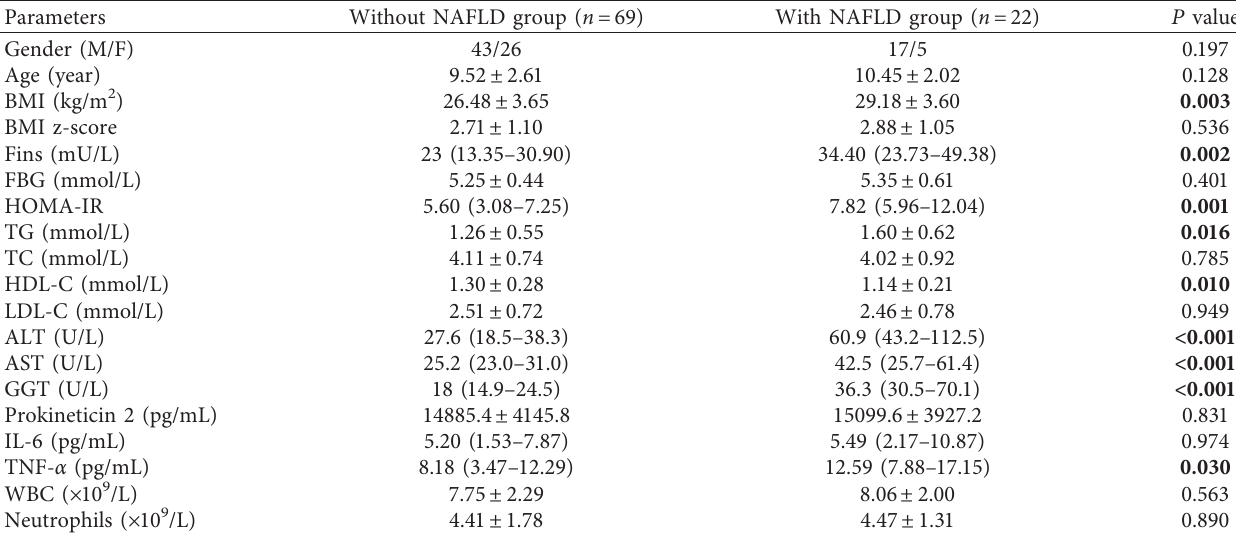
Table 2: Comparison of clinical and laboratory parameters between obese group with or without NALFD.